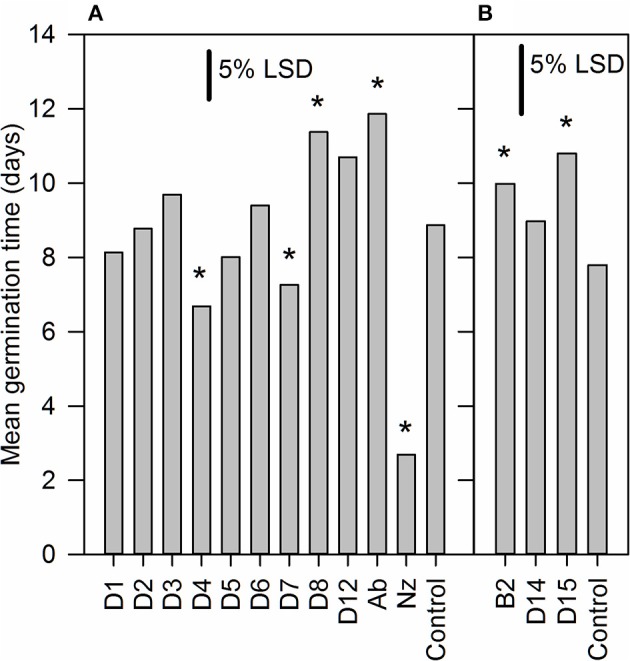
Identification of hydroxamic acid compounds that promote seed germination. Seed of an LeNCED1-overexpressing tomato line (sp12) were imbibed on filter paper wetted with 1 mM of 12 different hydroxamic acid compounds (D1–D8, D12, D14, D15, and B2), abamine (Ab), or 1.8 mg l−1 norflurazon (Nz). Each solution contained 0.2 mM NaOH and 0.2% DMSO, required for solubilization. The control solution contained only 0.2 mM NaOH and 0.2% DMSO. *Indicates significant difference compared to control at p < 0.05. Two independent experiments were carried out in (A,B), with the same control treatment. Floating bars represent least significant difference (LSD) between any two means within an experiment at 5% level, from ANOVA (n = 3).